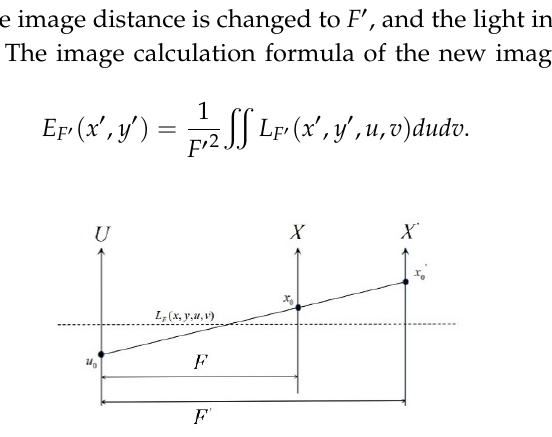
Figure 4. Schematic diagram of light field refocusing. The plane X is the first imaging state, and the plane X ’ is the refocused imaging state.